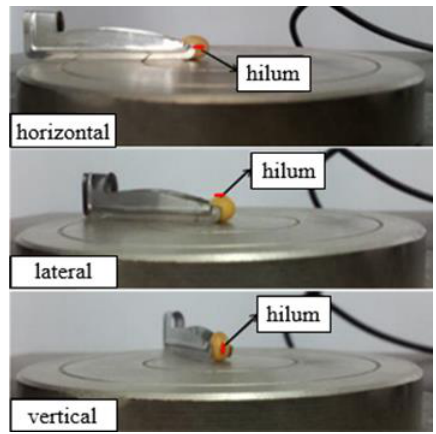
Figure 1. Placement of soybean seed particles. Taking SN42 as an example, during the loading process, the test force was gradually increased with an increase in deformation before the abrupt change of the test force. The curve is divided into three sections for discussion. In the first section, the deformation (0–0.01 mm) is very small, the test force is small and the growth trend is not obvious; in the second section, the deformation (0.01–0.05 mm) is small, and the test force increases slowly in this range; in the third section, the deformation (0.05–0.4 mm)is larger, and the test force basically grows linearly, as shown in Figure 2.